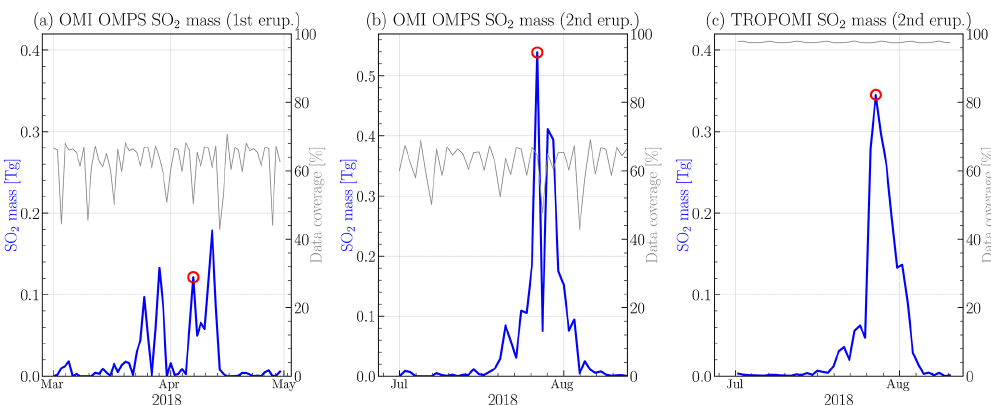
Figure C1. SO 2 mass for both April and July eruptions, as calculated from combined OMI/OMPS-NM